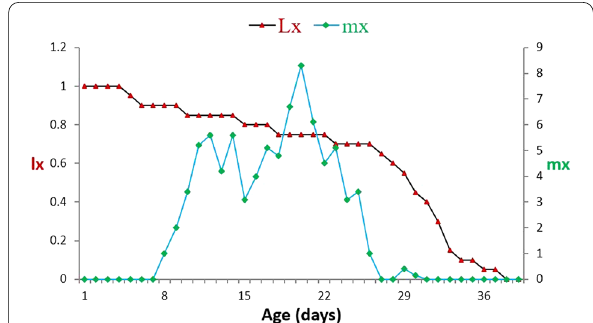
Fig. 4 Age specific survival ( l x ) and fertility ( m x ) of adult female H. dimidiata fed on R. padi aphid at 28